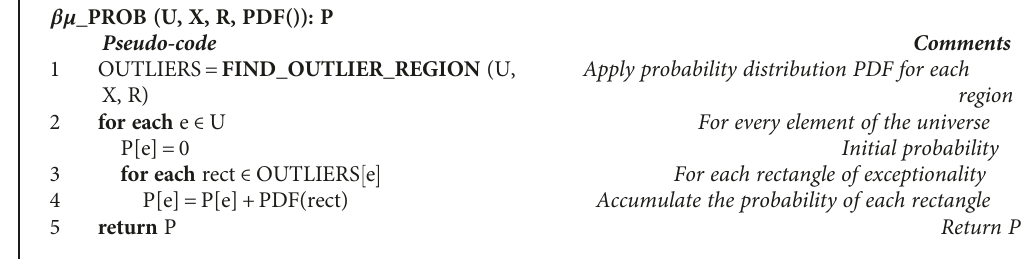
Algorithm 4: Pseudo-code of the βμ _PROB